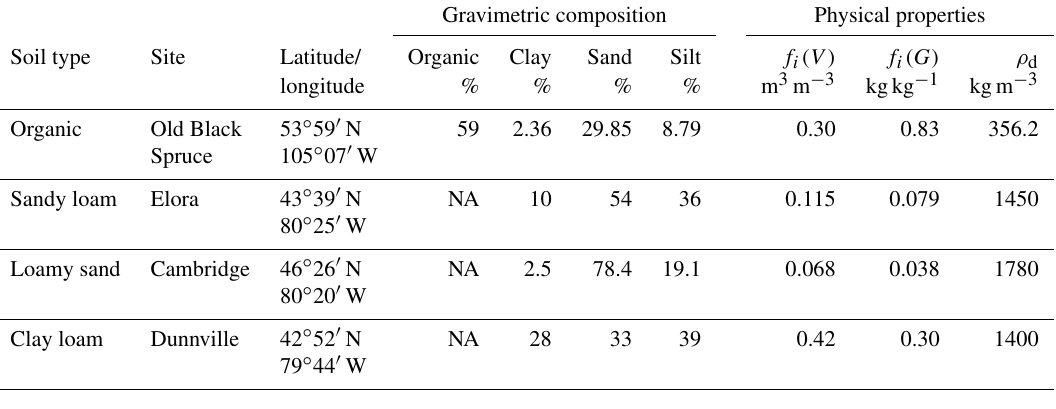
Table 1. Soil composition and physical properties. The Old Black Spruce site is located in the boreal forest in Saskatchewan, Canada, and the three other sites are located in agricultural fields in southern Ontario, Canada. f i (V ) and f i (G) stand for volumetric and gravimetric liquid water content, respectively. ρ d stands for dry bulk density.